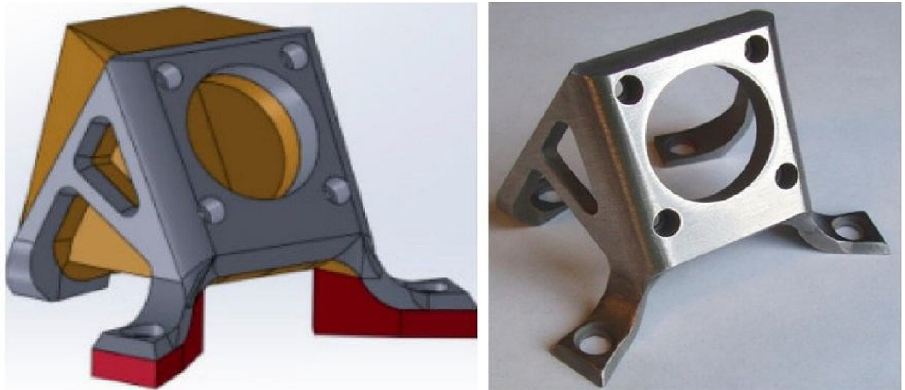
Figure 10. Using cold-spray technology to prepare a steel support [74].